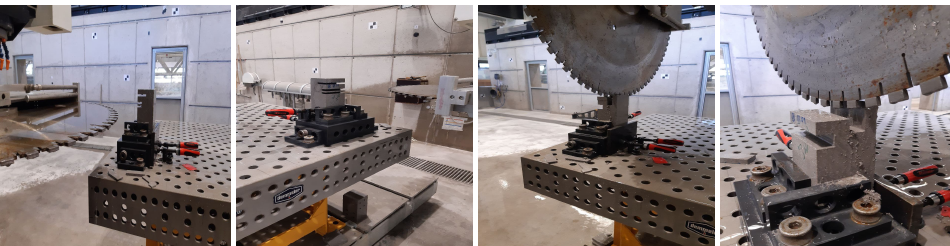
Figure 22. F7: milling process ( left to right ); duration: 20 min, speed: 80 (mm/min), Ra: 500 (rad/min), (DBFL, ITE and